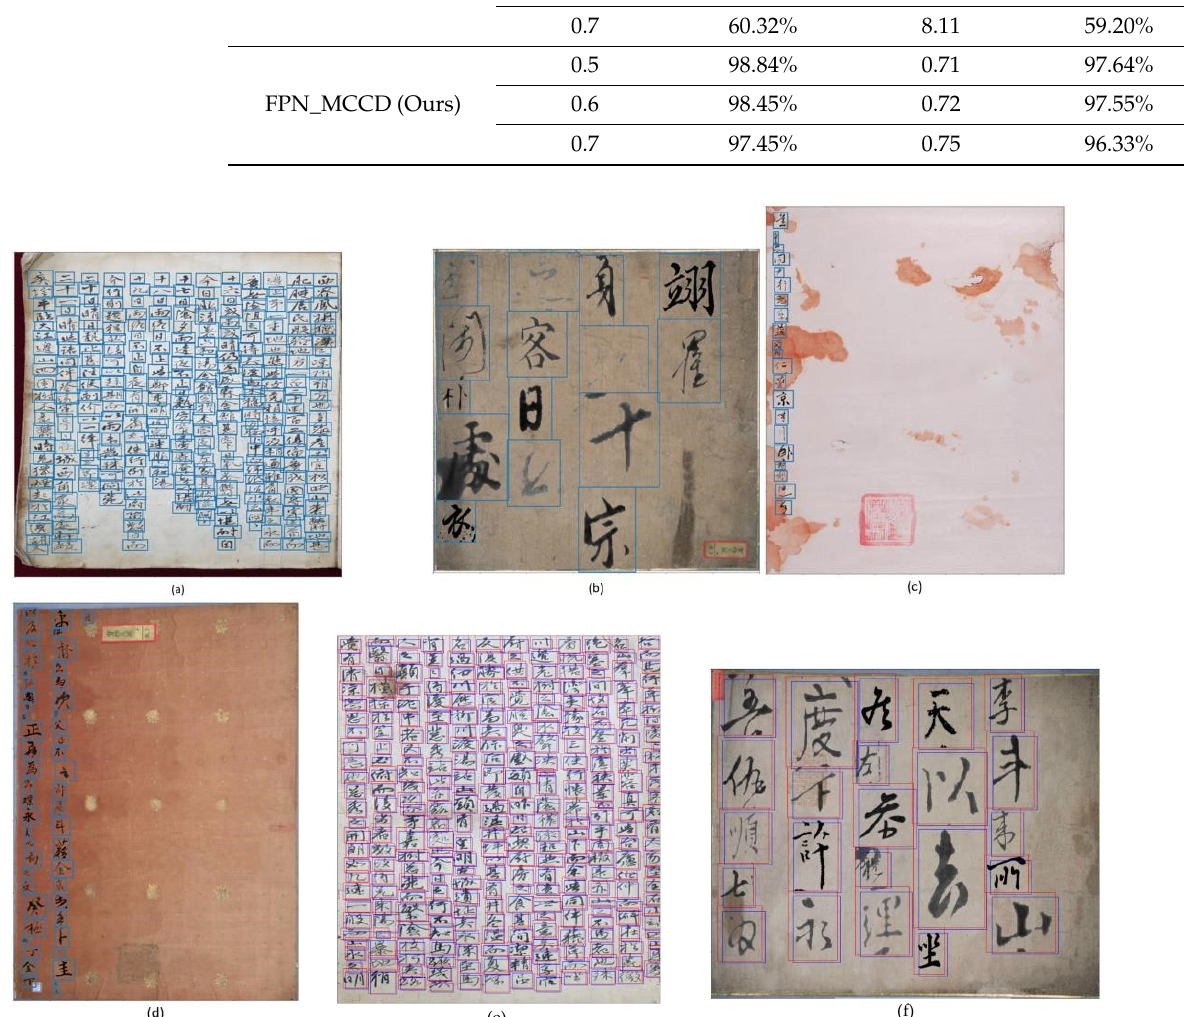
Figure 7. The results of the proposed FAN-MCCD that effectively adapts all different scales of characters in all different kind of KNU datasets. ( a ) The detection result on Caoshu dataset with dense distribution and different sized characters. ( b ) The detection result on Src-images dataset with very large multi-scale characters. ( c , d ) The result on Character dataset with a small number of various scales of characters. ( e , f ) The results with predicted bounding boxes (blue) overlaid with ground truth bounding boxes (red).